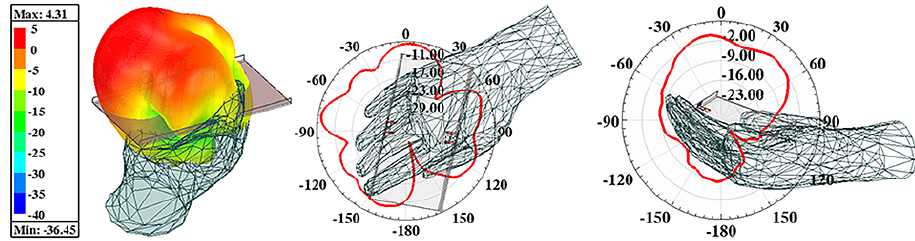
Figure 9. Simulated 3D and 2D radiating patterns of the proposed AP when Port 1 is excited at 3.5 GHz.